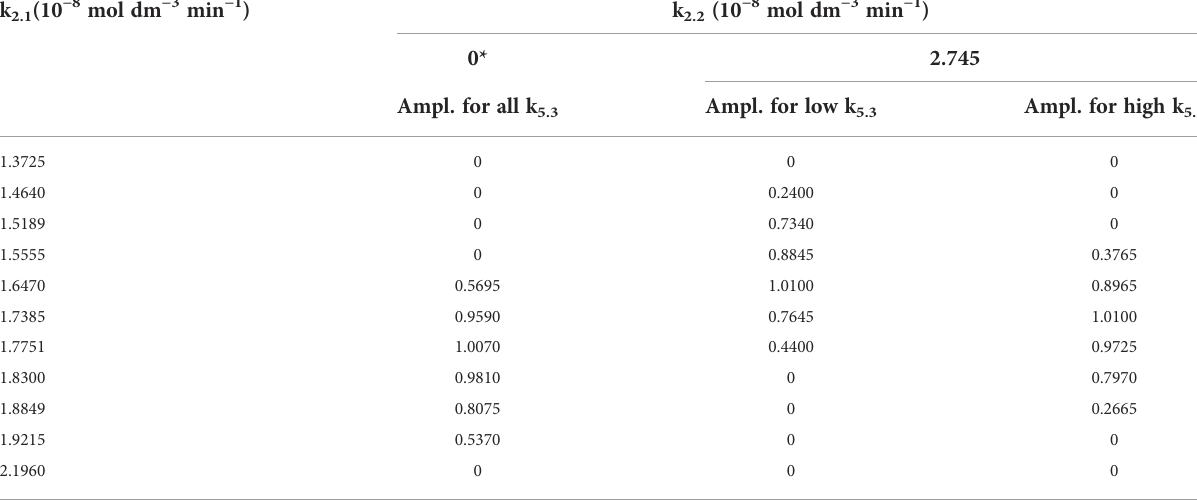
TABLE 2 Oscillation amplitudes of cortisol (Ampl.) in 10 − 8 mol dm − 3 for two fi xed values of k 2.2 and varied values of k 2.1 .